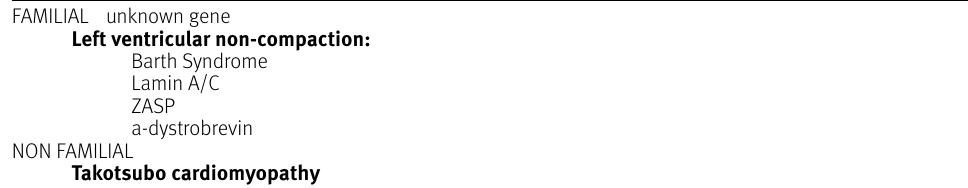
Table 5. Unclassified